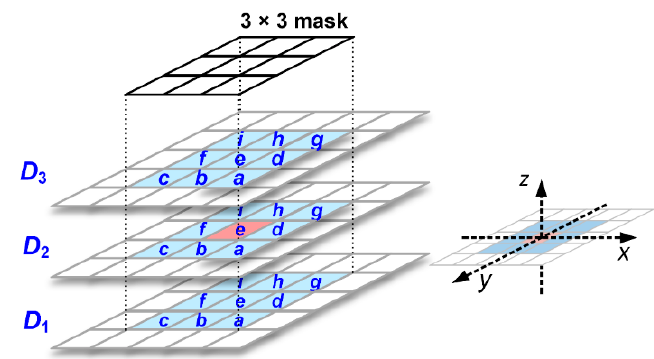
Figure 10. The detection range includes 27 pixels in three DoG images under a 3 × 3 mask, where the orange pixel is regarded as the detection point.